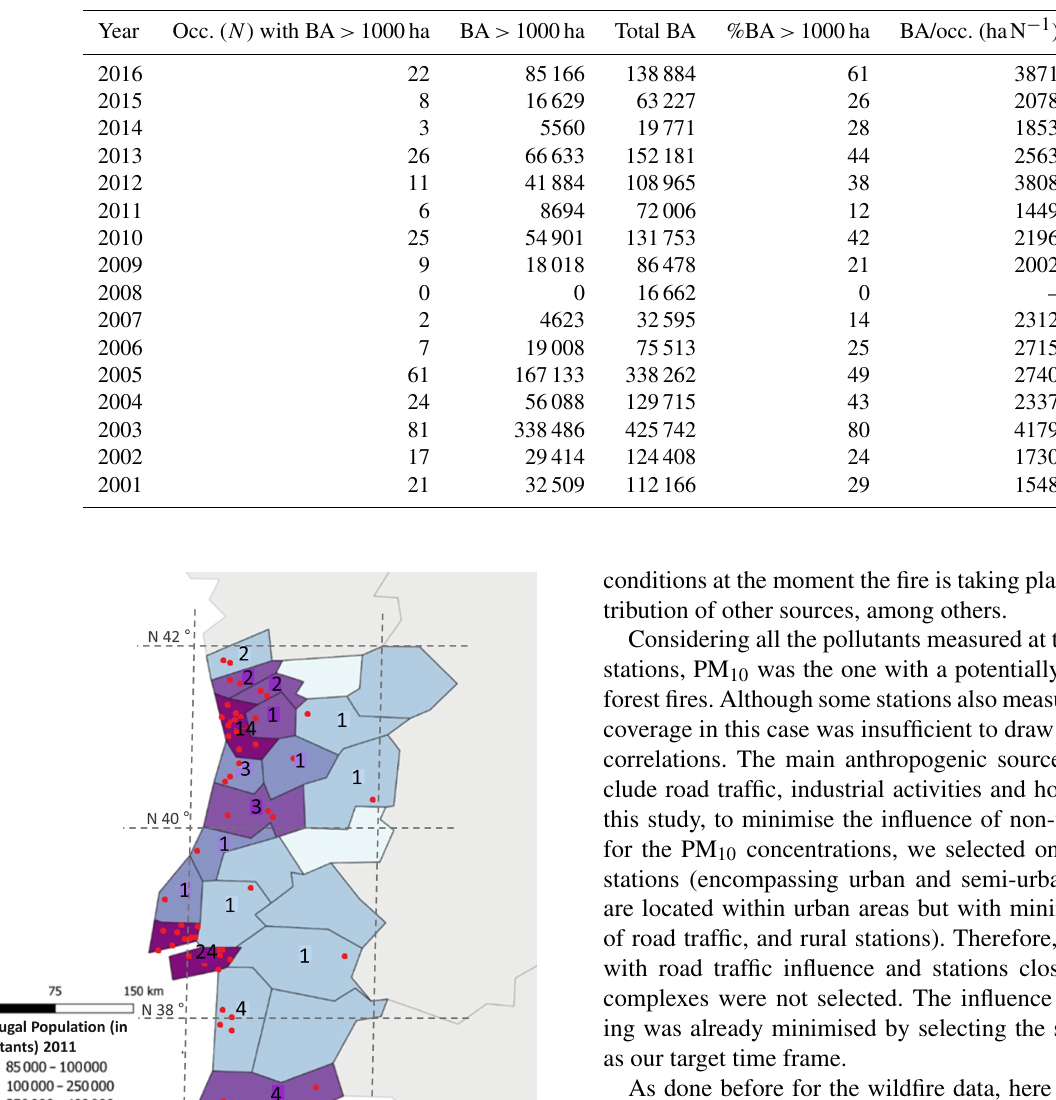
Table 1. Number of wildfires and burned area (BA) by year for the period 2001–2016 in mainland Portugal. From left to right: number of occurrences (occ.) when the burned area is larger than 1000ha; sum of the burned area for fires larger than 1000ha; total burned area caused by all fires; percentage of burned area caused by large fires; and index between burned area and the number of occurrences.